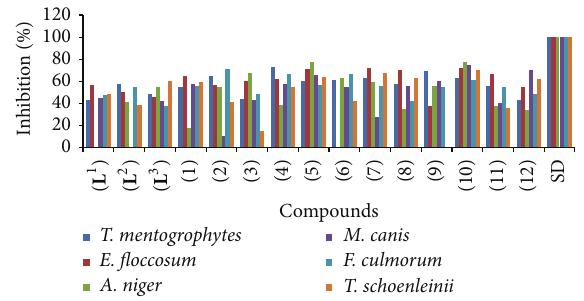
Figure 2: Comparison of antifungal activity of Schiff bases versus metal(II)